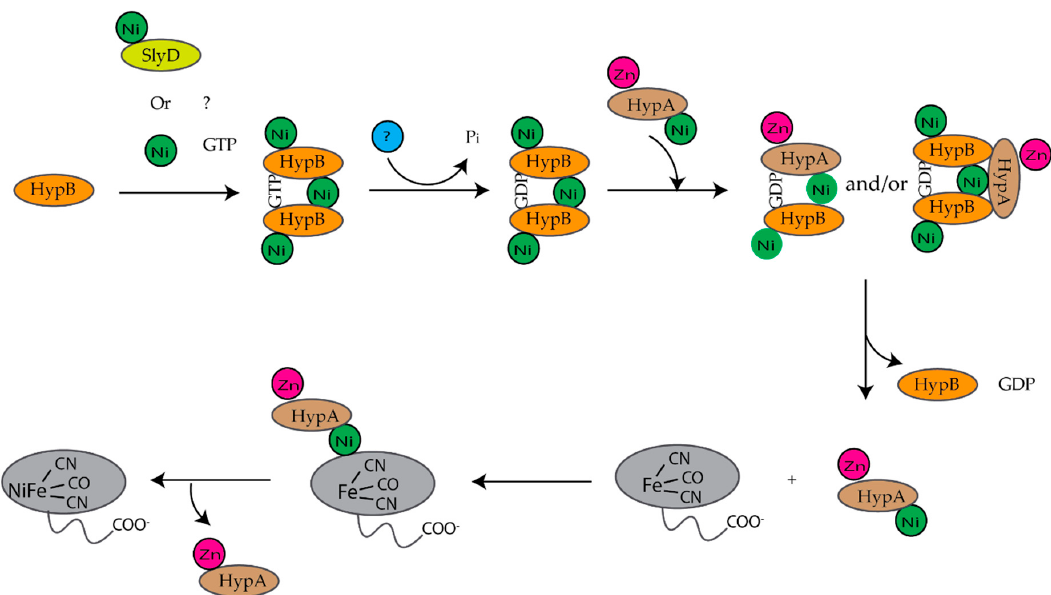
Figure 12. Model of the protein complexes required for the insertion of nickel into the large [NiFe]-hydrogenase precursor protein in E. coli [17,117,135]. Monomeric HypB dimerizes when it binds to GTP and then binds to nickel from SlyD or some other source. GTP hydrolysis occurs, which weakens the affinity of HypB for nickel and promotes the formation of a complex between NiGDPHypB and ZnHypA. Nickel is transferred from NiGDPHypB to ZnHypA. NiZnHypA then delivers nickel to the large [NiFe]-hydrogenase precursor protein.